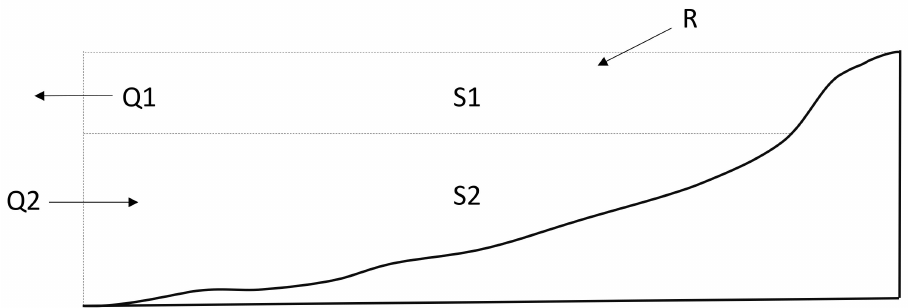
Figure 2. Box model chart applied to estimate renewal times in the harbours of Tarragona and Castell ó n, which comply with this circulatory pattern, typical of positive estuaries.